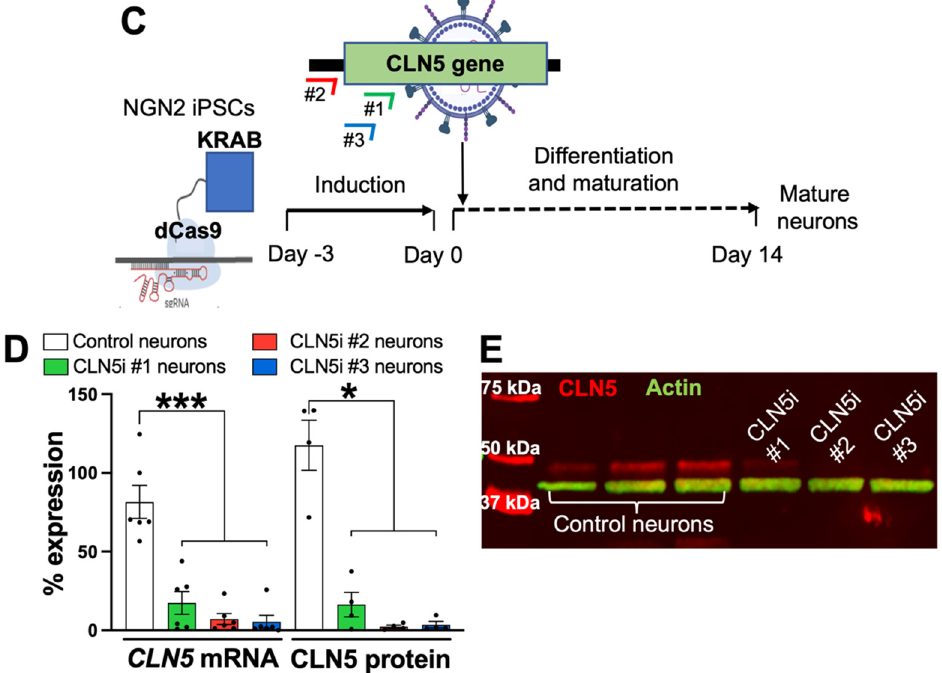
Figure 1. iPSC-derived human cortical-like glutamatergic neurons mimicking CLN5 Batten disease. ( A ) Schematic of iPSC-derived human neuron generation. Three days of induction and fourteen days of differentiation and maturation generates pure human cortical-like glutamatergic neurons. ( B ) iPSCs with integrated neurogenin-2 can be efficiently differentiated into pure human cortical-like glutamatergic neurons expressing neuronal markers. ( C ) CRISPRi strategy to inhibit CLN5 in iPSC- derived human neurons. Three sgRNAs against CLN5 were transduced using lentiviruses into iPSC- derived human neurons containing dCas9 machinery. ( D,E ) All three sgRNAs showed significant inhibition of CLN5, both at the transcript (D) and protein levels (D,E). (E) First three lanes are control neurons, and following three lanes are CLN5i neurons. n ≥ 4, * p < 0.05, *** p < 0.001.